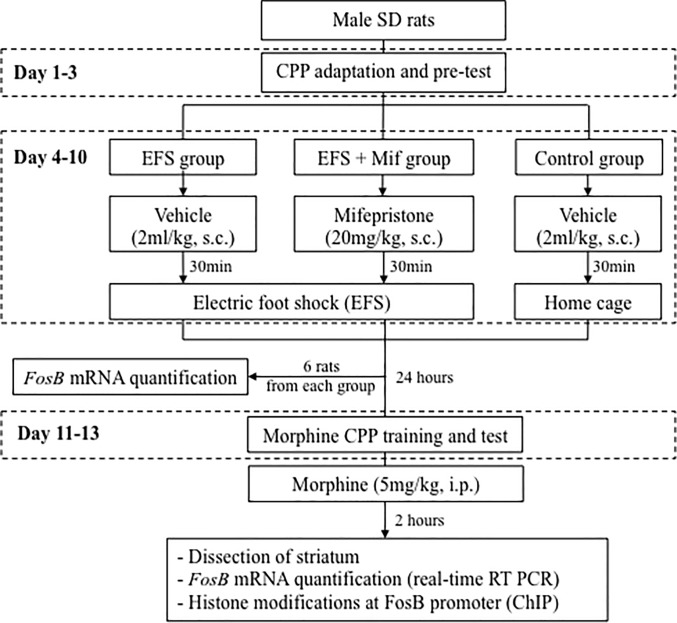
Experimental design.